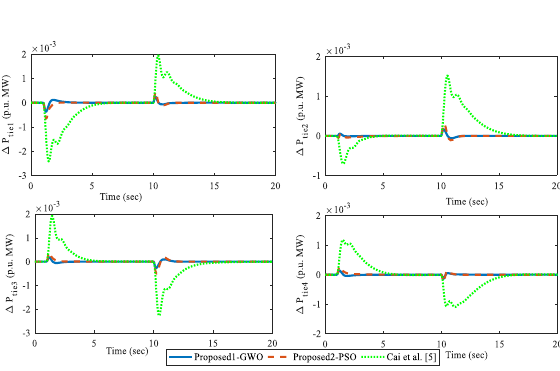
Fig. 27 Comparison of tie-line power flow for FAPS in